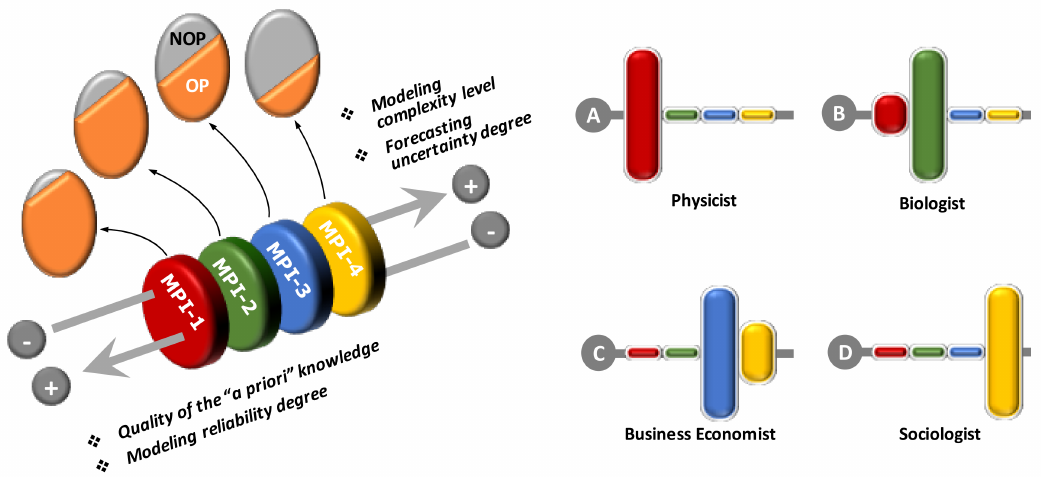
Figure 4. Schematic approach to describe the definition of Macrodomain of Prevailing Interest (MPI). Left side: a system can be seen as divided into two parts: observable (OP, orange) and unobservable (NOP, grey). The larger the observable part, the higher the quality and details of the knowledge we have of a system, with a direct e ff ect on the quality of the information that a ff ects the decision-making capacity on the system itself. Four di ff erent information quality levels can be identified, corresponding to the four MPIs described in the text. Right side: the qualitative decision-making profile of a decision-maker can be then described as a combination of di ff erent MPIs; some examples of “pure” professional standpoints are here